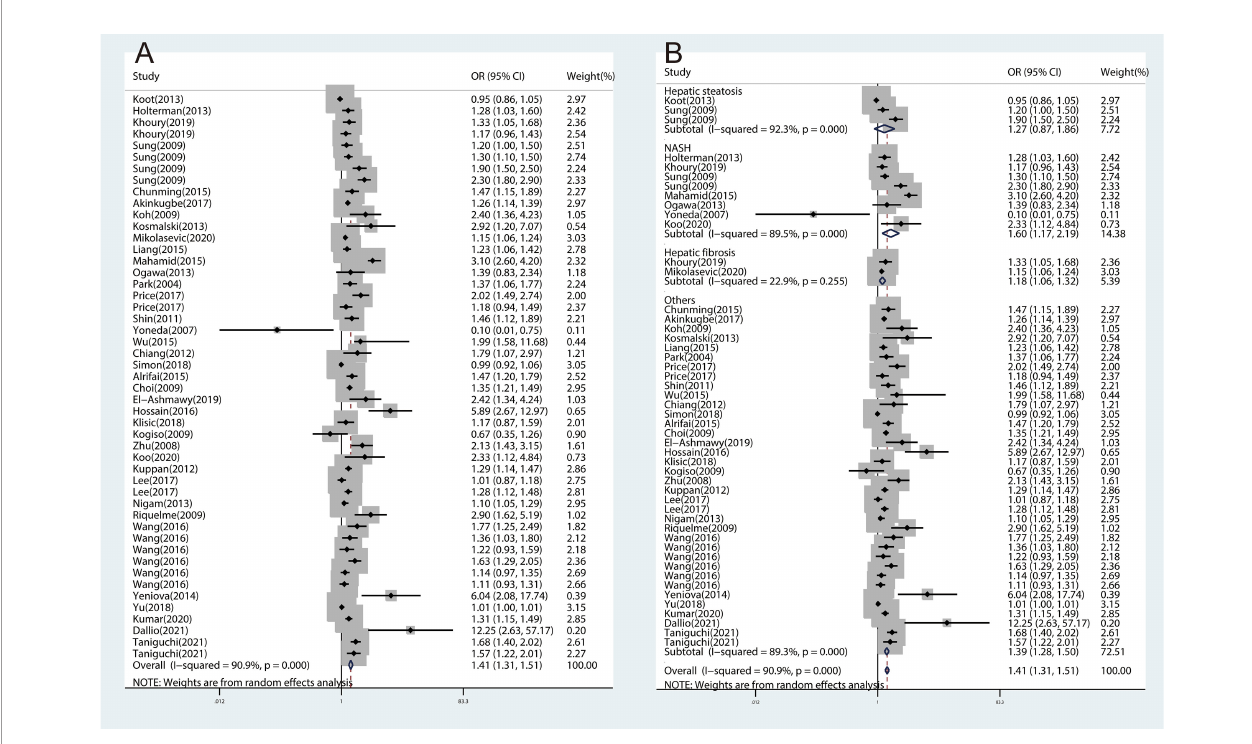
FIGURE 2 | The forest plots of the association between CRP and NAFLD and subtypes of NAFLD. (A) , Association between CRP and NAFLD. (B) , Association between CRP and subtypes of